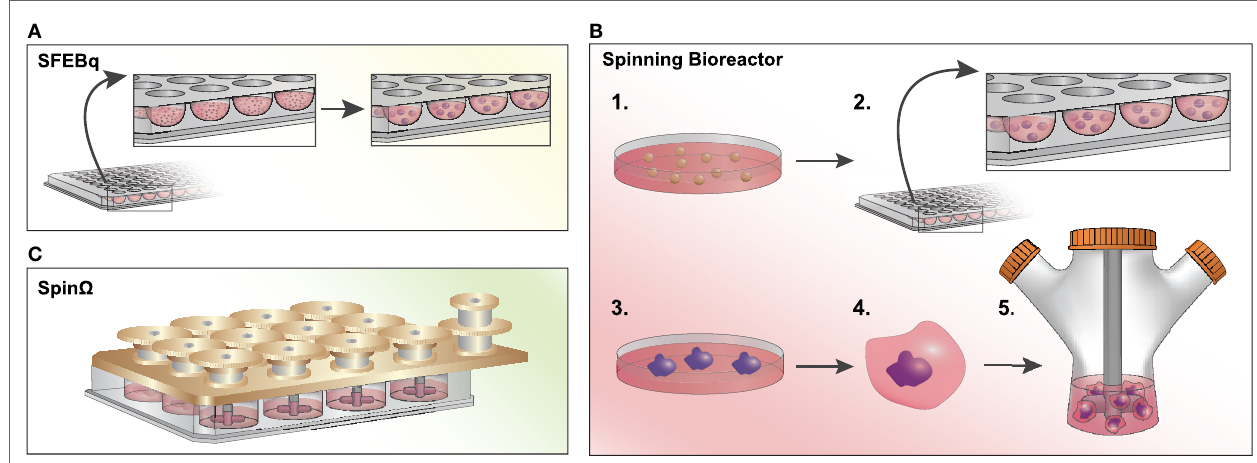
FigURe 2 | Methods to generate brain organoids in vitro . (A) Serum-free, floating culture of embryoid bodies with quick reaggregation (SFEBq): pluripotent stem cells (PSCs) are dissociated and resuspended in a low-adhesion, U-bottomed 96-well plate in serum-free culture. Cells will quickly reaggregate (within an hour) into uniformly sized masses and will differentiate into neural progenitor cells within ~10–12 days after plating in N2-supplemented media. (B) Spinning Bioreactor: 1. PSCs are dissociated and 2. cultured in a low-adhesion plate in hES media with low bFGF and a ROCK inhibitor. 3. Embryoid bodies are cultured in neural induction medium and begin to form neuroepithelial tissues. 4. Tissues are transferred into Matrigel droplets and four days later are 5. transferred to a spinning bioreactor with differentiation media. (C) Spin Ω : A spinning device is fitted over a standard 12-well culture plate, with 13 interconnecting gears driven by a motor agitating the culture media. Similar to the spinning bioreactor approach, cells are embedded in Matrigel droplets prior to spin culture. This technique significantly reduces the cost and space constraints associated with spinning